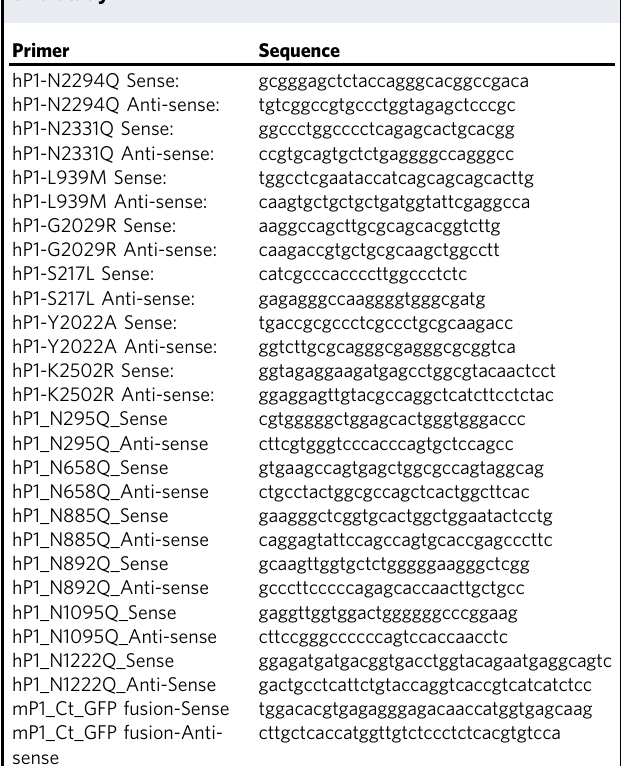
Table 1 Primers used for site directed mutagenesis in this